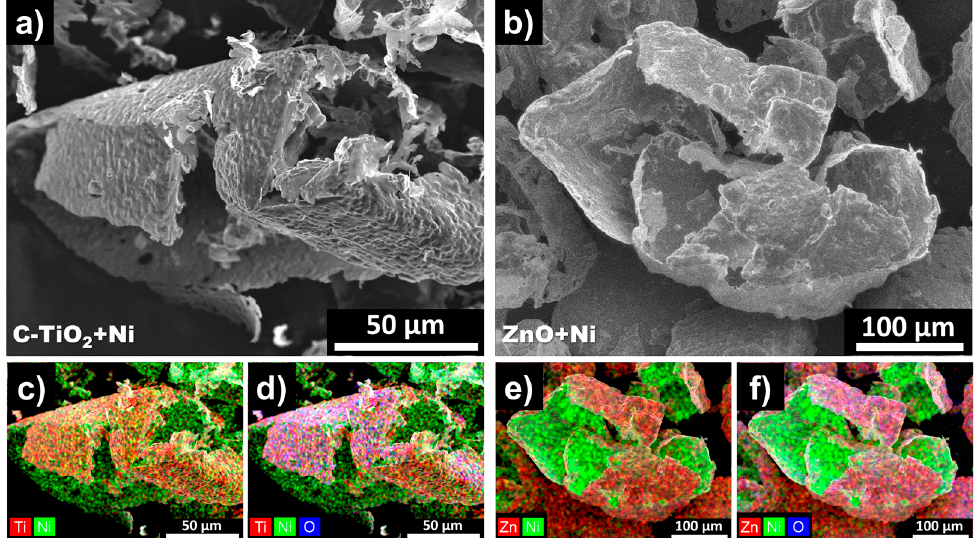
Figure 1. SEM images and EDS elemental maps of typical MP particles: ( a ) SEM image of C-TiO 2 +Ni; ( b ) SEM image of ZnO+Ni; ( c ) elemental map of C-TiO 2 +Ni excluding oxygen; ( d ) elemental map of C-TiO 2 +Ni including oxygen; ( e ) elemental map of ZnO+Ni excluding oxygen; ( f ) elemental map of ZnO+Ni including oxygen. Red color represents Ti and Zn, green represents nickel, and blue represents oxygen. In images ( d ) and ( f ) pink color regions are the result of an additive mixing of red and blue colors, therefore pink can be considered as the representative of C-TiO 2 and ZnO photocatalysts distribution.